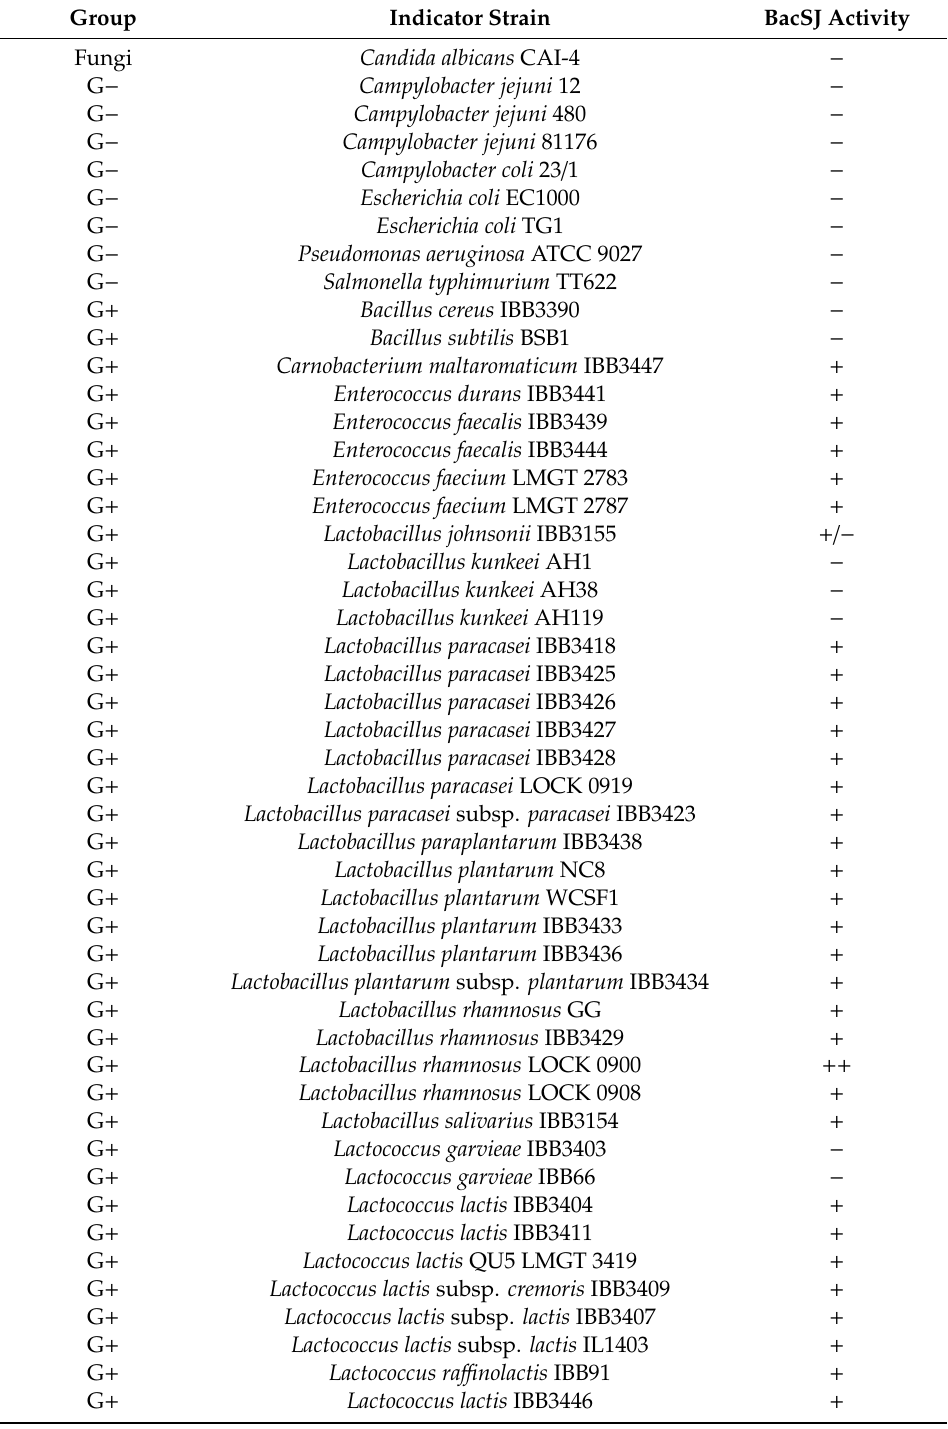
Table 1. Inhibitory spectrum of